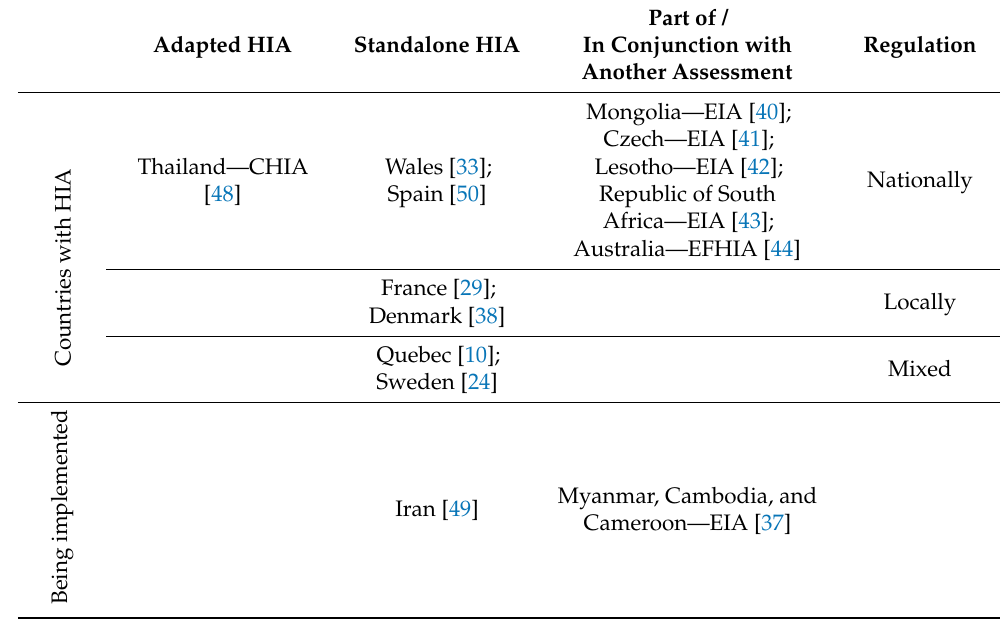
Table 1. Types of implemented HIA